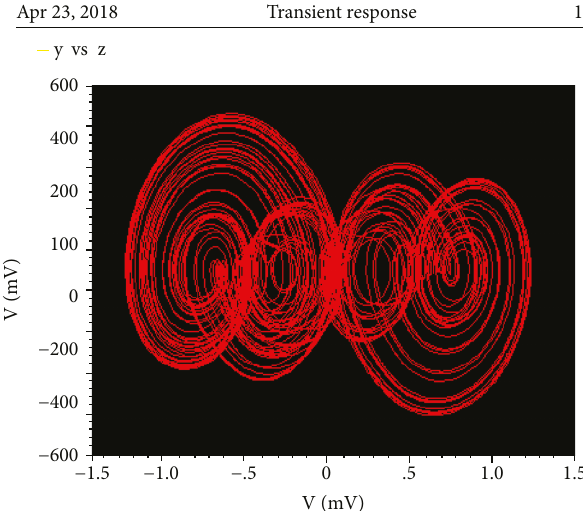
Figure 20: The phase portrait in the x - y plane (S turned on).